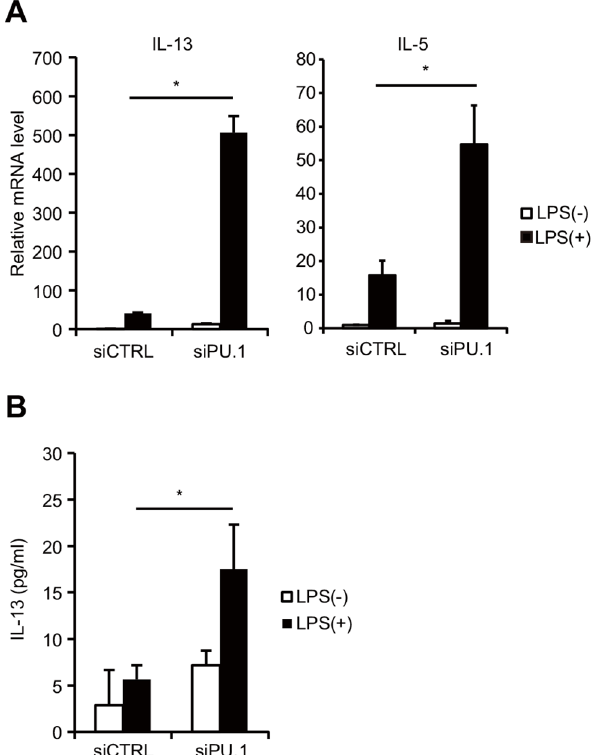
Fig 1. Effects of PU.1 knockdown on Th2 cytokine expression. BMDCs were transfected with either control (siCTRL) or PU.1 (siPU.1) siRNA and were then incubated for 48 h prior to stimulation with (closed bars) or without (open bars) 1 μ g/ml LPS for 6 h. (A) Relative mRNA levels were determined by quantitative RT-PCR after normalization to GAPDH mRNA. Data are expressed as the ratio of the expression level of respective control siRNA-introduced cells without LPS stimulation. (B) IL-13 protein concentrations in the supernatant were measured using ELISA. All results are means ± S.E.s ( n = 3). Similar results were obtained in three separate experiments. * , p < 0.05 in a two-tailed paired Student ’ s t test.